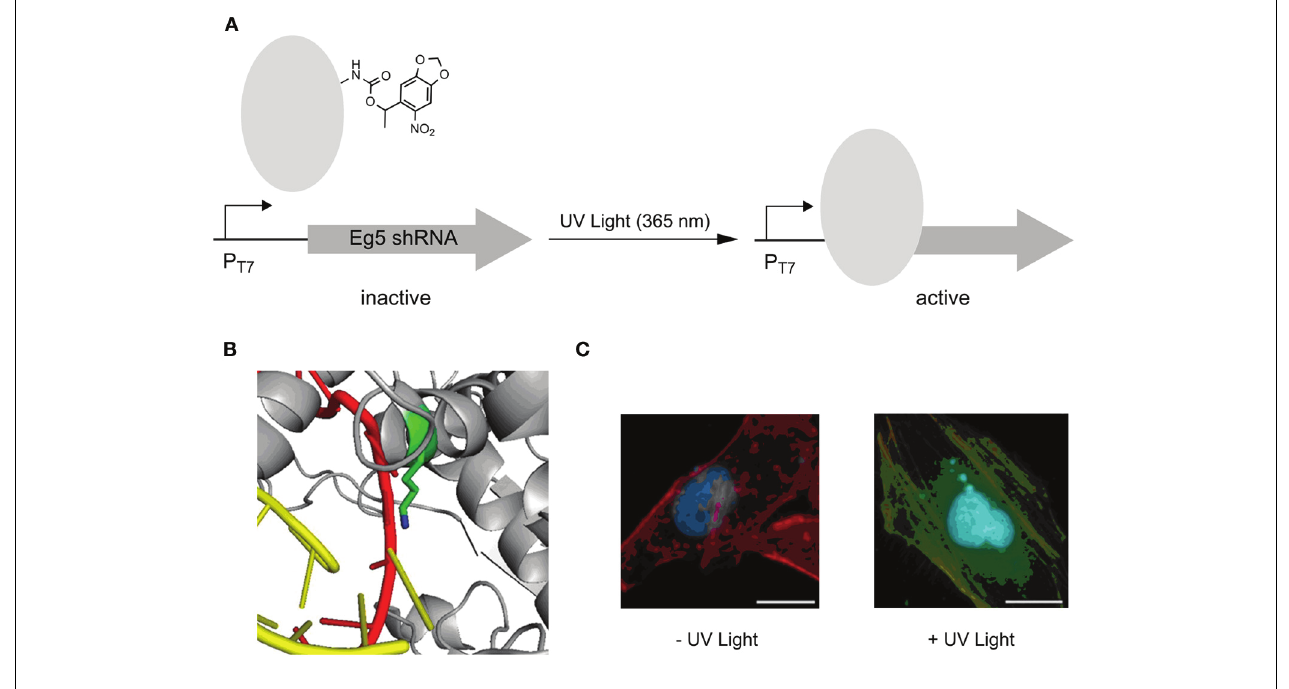
FIGURE 3 | Photoactivation of T7 RNA polymerase using photocaged lysine 5. (A) General principle of activation of transcription of an anti-Eg5 shRNA. (B) Position of lysine used for replacement with 5, resulting in an inactive T7 RNA polymerase.